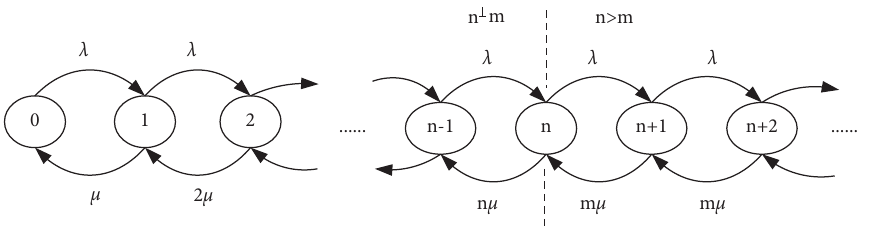
Figure 8: State transition of a battery swapping station